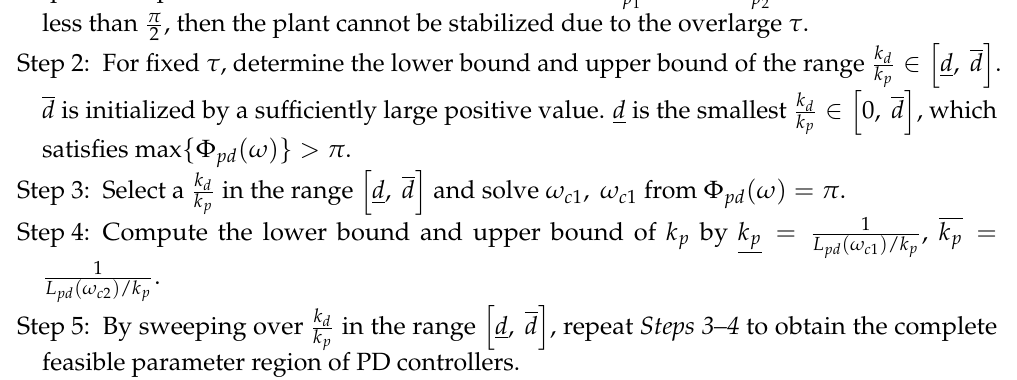
Algorithm 1 for computing the PD parameter region of the plant (Equation (6)) is